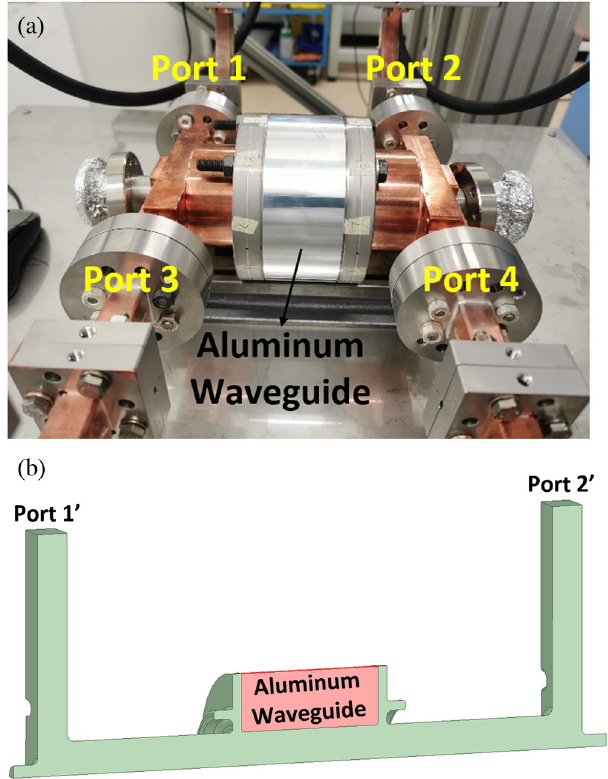
FIG. 16. The mechanical assembly (a) and simulation modeling (b) of two end-part prototypes and an aluminum waveguide (see first row of Table